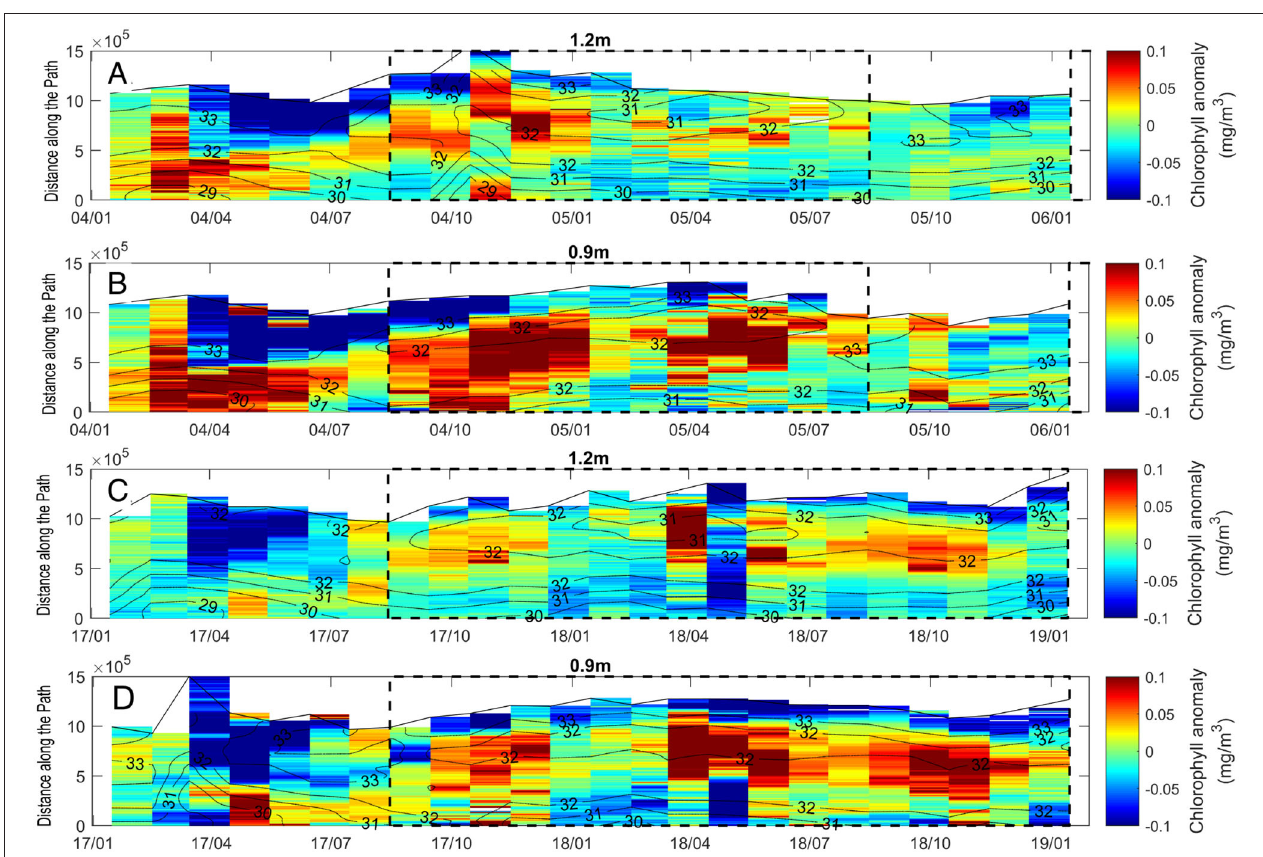
FIGURE 6 | Monthly chlorophyll anomaly extracted during the two large meander periods shown in color as a function of time and distance along the Kuroshio path with different definitions of the Kuroshio axis with the SSH values for (A,C) 1.2 and (B,D) 0.9 m. (A,B) shows LM 2004–2005 and (C,D) LM 2017–2019. Black dashed line indicates the large meander periods. Black dotted contour indicates the latitude.